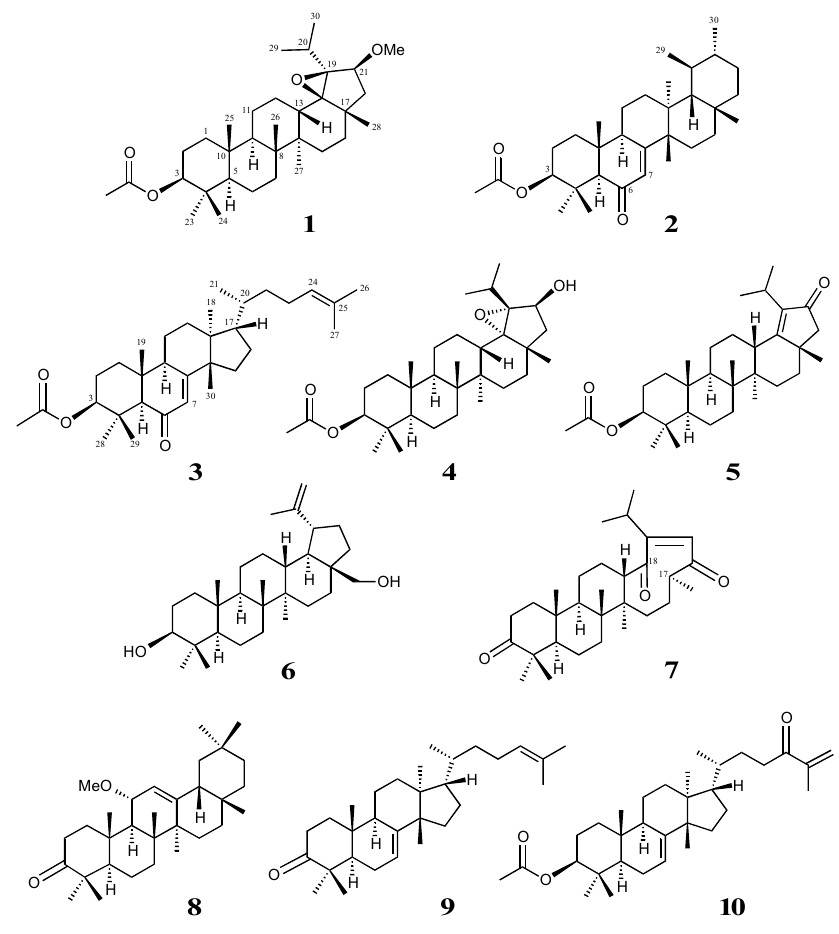
Figure 1. Chemical structures for compounds 1 – 10 .